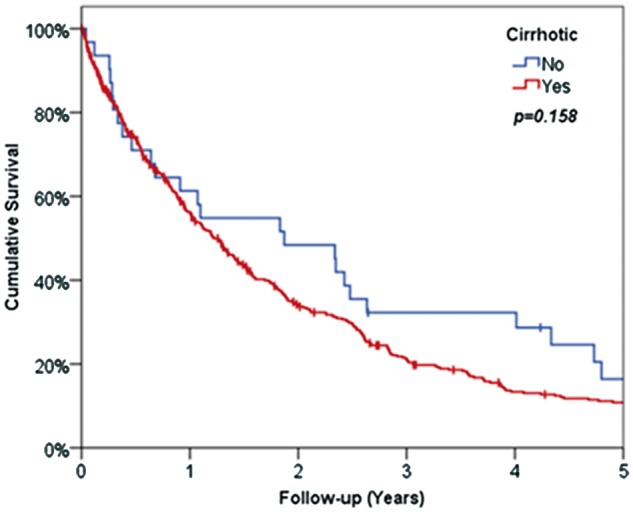
Kaplan-Meier survival curve for patients with cirrhosis and without cirrhosis.